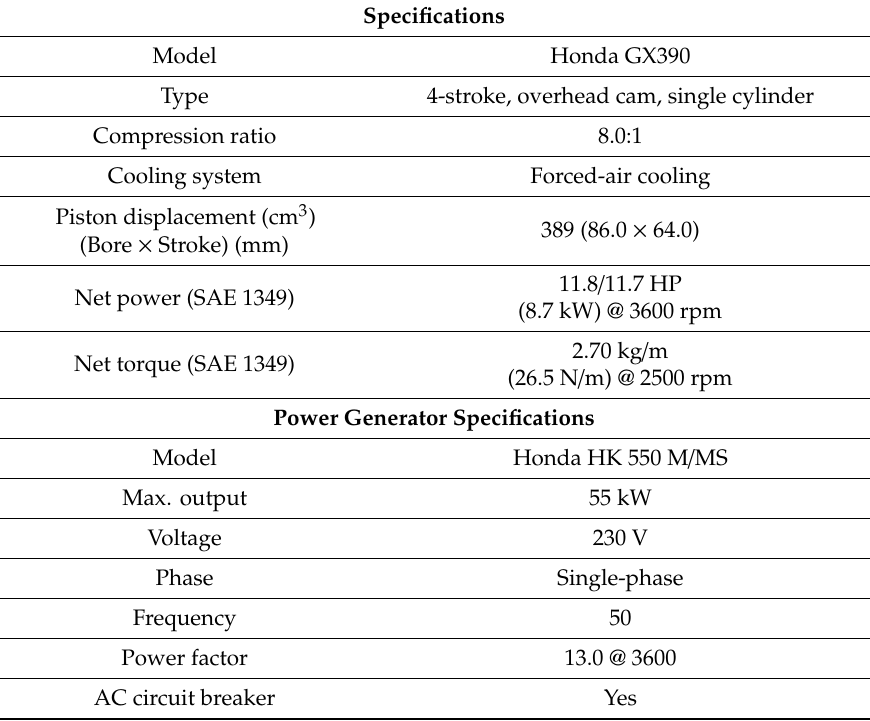
Table 4. Technical specifications of the test